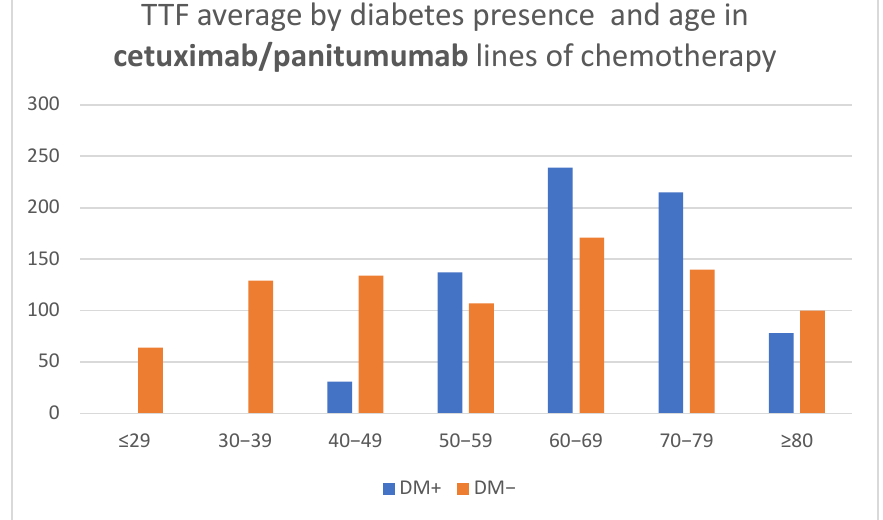
Figure 6. Time to treatment failure (TTF) average by diabetes presence and age in cetuximab/panitumumab lines of chemotherapy.